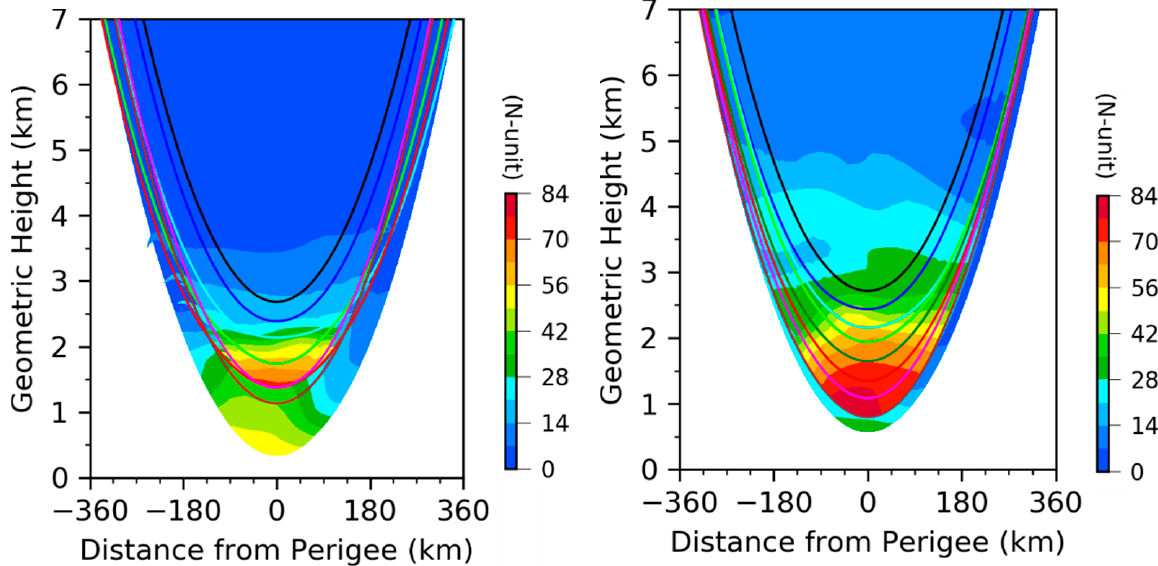
Figure 3. Variations in the geometric height of eight simulated ray paths (curves) and ERA5 wet refractivity N wet ( N -unit shaded in color) for RO1 ( left ) and RO2 ( right ). The GPS and LEO satellite positions are to the left and right directions on the x -axes, respectively. For clarity, every other simulated ray is plotted.